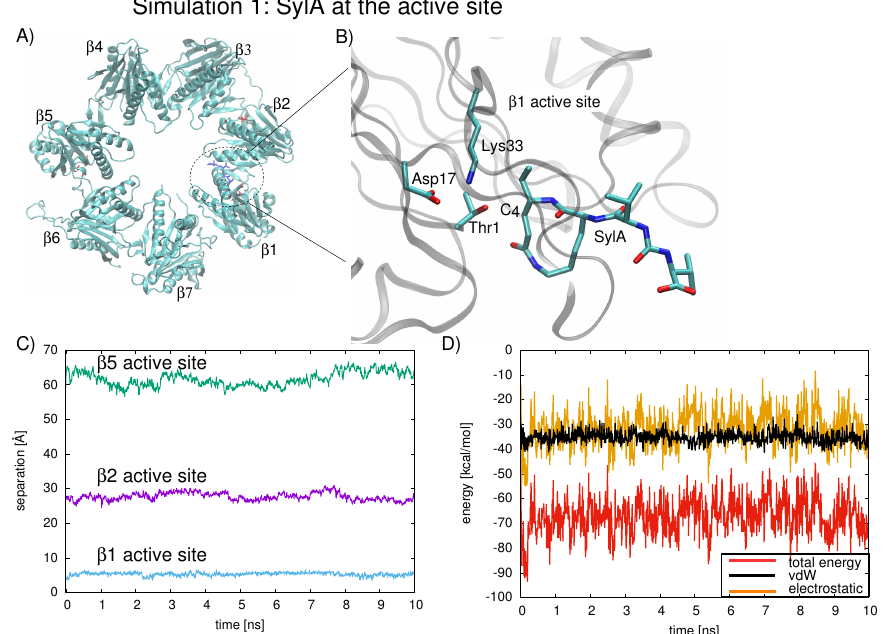
Figure 2. ( A ) Snapshot of the B 1 ring shown from above, highlighting active site residues (red stick representation) and SylA inhibitor (blue stick representation) at t = 0.0 ns (circled in dotted line), as co-crystallized in the proteasome near the active site of the β 1 subunit (PDB ID 2ZCY [6]). ( B ) Up-close view of the region within the dotted line showing SylA inhibitor at t = 0.0 ns, as co-crystallized in the proteasome near the active site of the β 1 subunit (PDB ID 2ZCY [6]), is depicted, with residues (Thr1, Asp17, and Lys33) involved in binding the SylA inhibitor labeled. For clarity, SylA and active site nitrogen atoms and oxygen atoms are colored blue and red, respectively; the remainder of the protein is depicted as gray ribbon. ( C ) The position of the SylA inhibitor during the MD is quantified by the separation between C 4 and Thr1-O γ of each active site, β 1 (blue line), β 2 (purple line), and β 5 (green line). ( D ) The total interaction energy between SylA and all seven B 1 subunits energy (red line) can be decomposed into van der Waal’s interactions (black line) and electrostatic interactions (orange line). Favorable electrostatic (orange line) and vdW (black line) energies are observed during the duration of the 10 ns simulation, in which the inhibitor is localized at the β 1 active